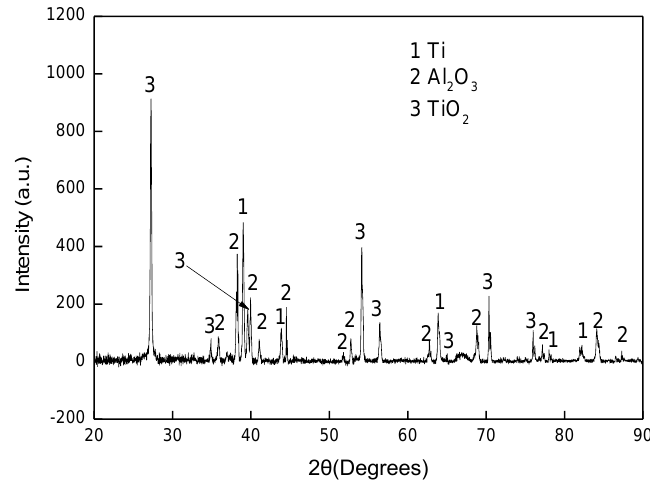
Figure 4. X-ray diffraction (XRD) pattern for cross-sectioned Ti heated up to 800 °C.